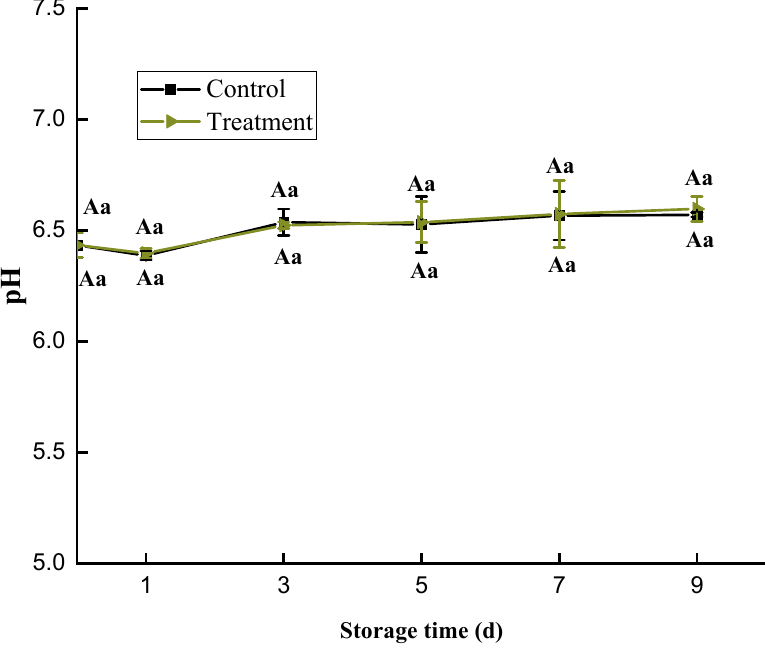
Figure 5. Changes in the pH of Trachinotus ovatus during refrigerator storage. Within the same group, different lowercase superscripts indicate significant differences ( p < 0.05). Among different groups, different capital letter superscripts indicate significant differences ( p < 0.05).